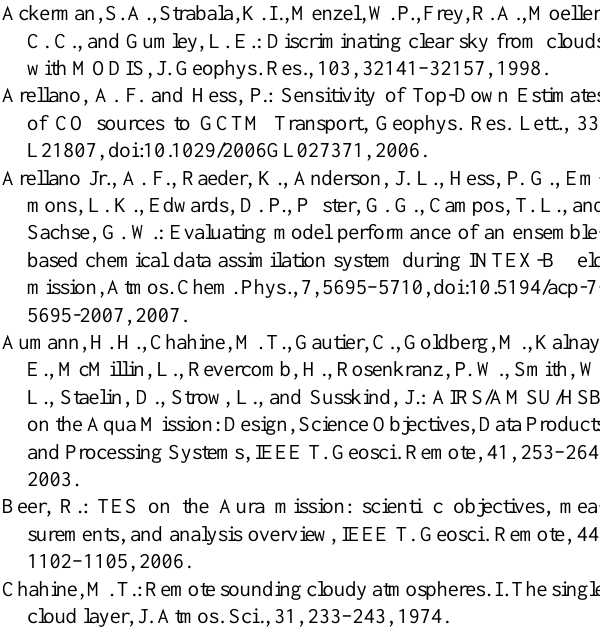
Fig. 9. The correlations between AIRS CO VMRs (ppbv) recent emissions at 500 hPa and the total emission amount of GFED3 and MACCity inventories for the NH (left panel) and SH (right panel), respectively.